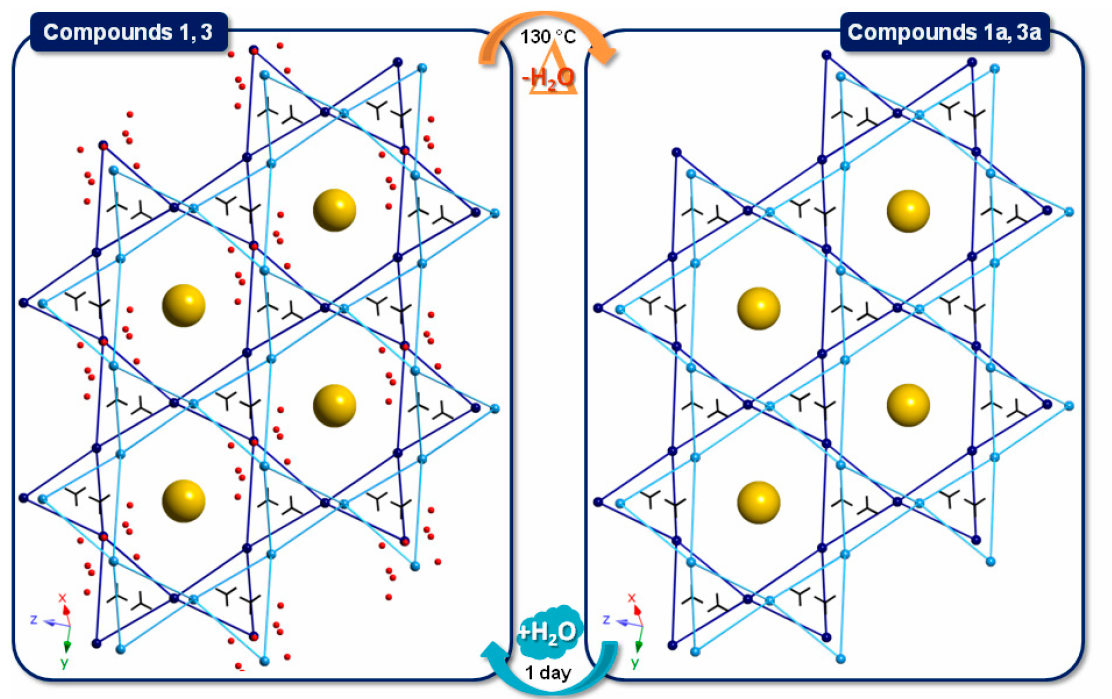
Figure 9. Guanidinium-templated Kagome-type double lattice of Cu II atoms in 1 and